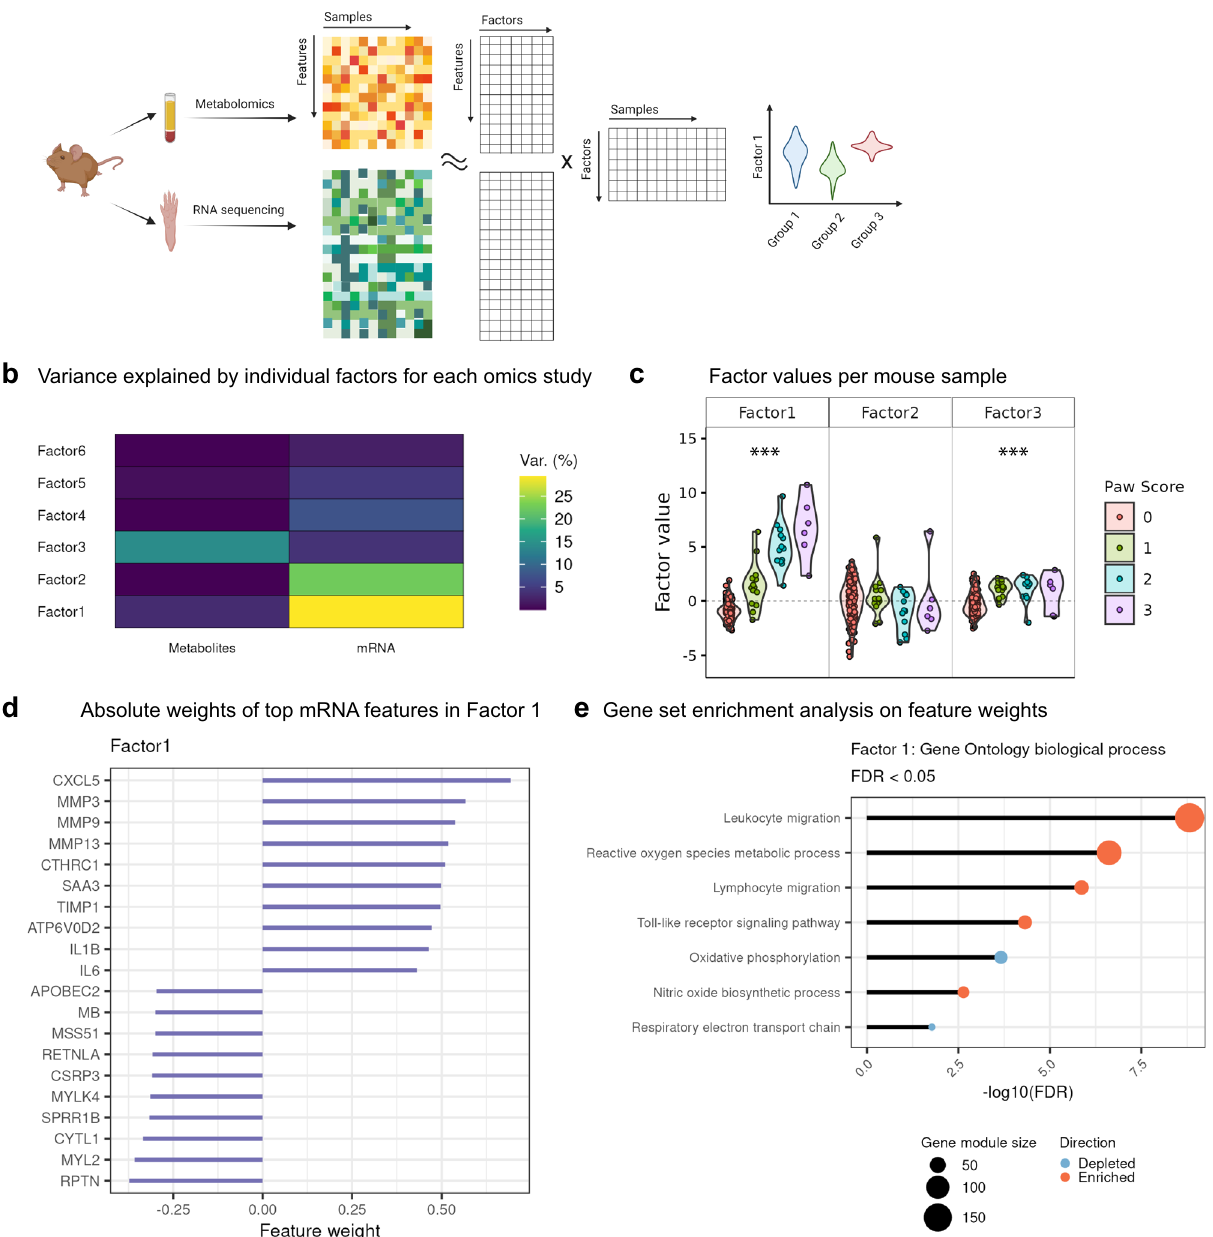
Figure 5. Multi-omics data integration identifies ROS as disease-correlated factor. ( a ) Overview of MOFA model. MOFA 37 is an unsupervised method for integrating multi-omics data. In this study, MOFA decomposes the data matrices of metabolomics and transcriptomics with co-occurrent samples into a weight matrix for each omics data and a matrix of factors for each sample. “Features” denote metabolites in metabolomics data, or mRNA in transcriptome data. Visualization of sample groups by factor values can identify factors associated with disease phenotypes. ( b ) Proportion of total variance (Var.) explained by individual factors for each omics experiment. ( c ) Visualization of samples using Factors 1, 2 and 3. The dots on violin plots represent mouse subjects. The colors denote the arthritis scores of the right hind paws. One-way ANOVA was used to assess if there is any significant difference among the subjects in the 4 score groups (p < 0.05*, p < 0.01**, p < 0.001***). ( d ) Absolute weights of the top features of Factors 1 in transcriptome data. ( e ) Gene set enrichment analysis on the feature weights of mRNA in Factor 1 (FDR <